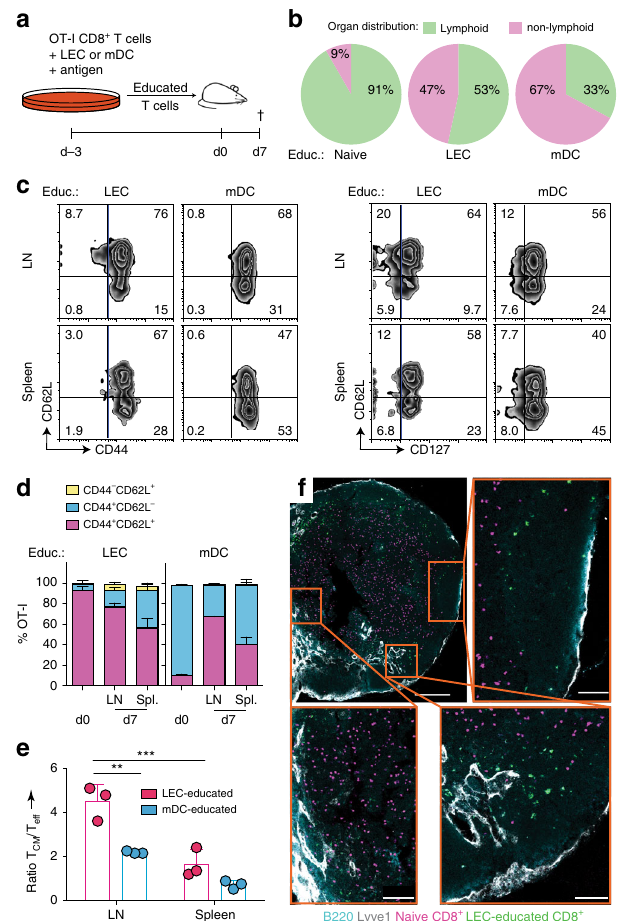
Fig. 6 CD62L expression in LEC-educated CD8 + T cells correlates with LN homing after in vivo transfer. a LEC-educated or mDC-educated CD45.1 + OT-I cells were transferred i.v. into healthy adult WT mice (10 6 cells/recipient), and various organs were analyzed one week later. b Recovered transferred cells within either lymphoid (LN, spleen) or non-lymphoid (liver and lungs) organs as a percentage of total recovered cells across these organs. c Representative fl ow cytometry contour plots depicting expression of CD44, CD62L, and CD127 gated on OT-I cells. d Distribution of T CM -like (CD44 + CD62L + ), T eff/EM -like (CD44 + CD62L − ) and naïve (CD44 − CD62L + ) subsets within LEC/mDC-educated cells before transfer (day 0) and at endpoint. e Ratio of T CM -like to T eff/EM -like cells. Data points and error bars indicate mean ± SD for n = 3 biological replicates from one of two independent experiments. ** p ≤ 0.01, *** p ≤ 0.001 via two-way ANOVA with Bonferroni ’ s post-test. f Top left, brachial LNs collected from healthy wild-type mice within 2 days after co-transfer of LEC-educated (green) and naïve (pink) OT-I cells were analyzed by imaging, with counterstains for Lyve1 (white) and B220 (cyan) for orientation. Overview wide-angle and close-ups of (top and bottom right) subcapsular sinus and B cell zones, and (bottom left) T cell zone. Scale = 200 μ m (top left), 70 μ m (bottom left), and 50 μ m (top/bottom right). Representative image from two independent